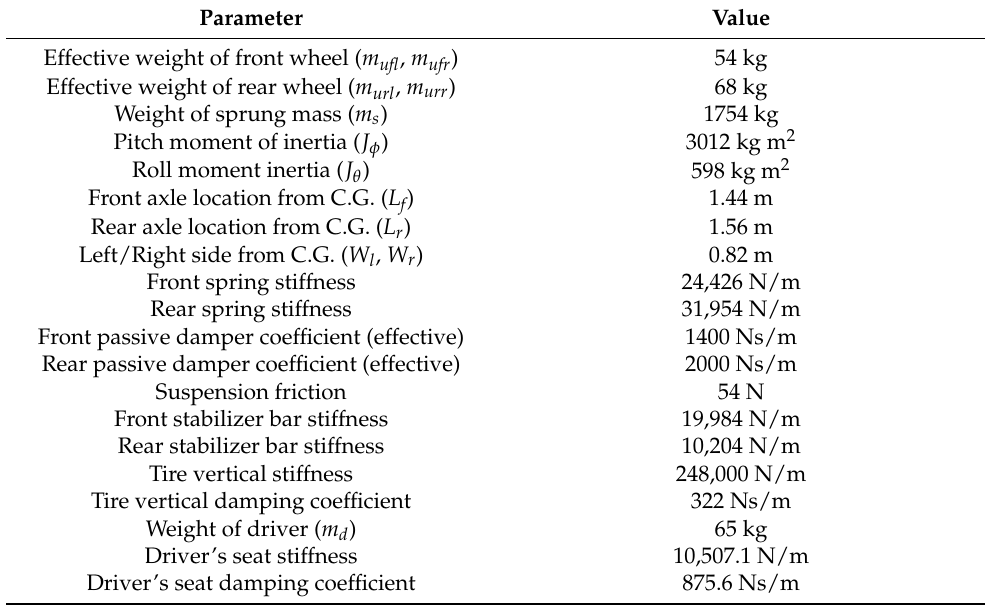
Table 2. Model parameters for a full car.